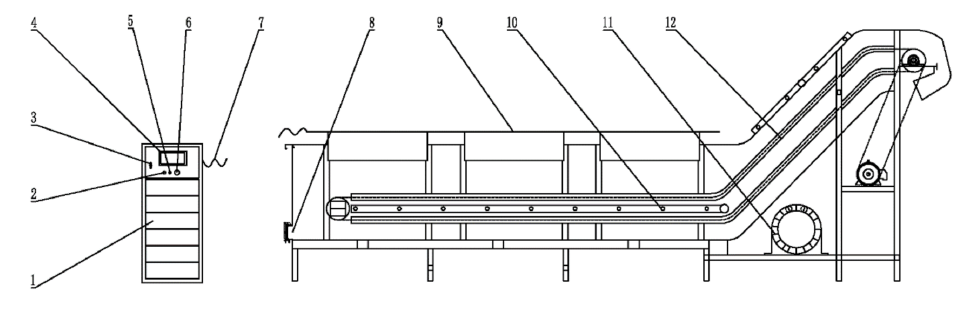
Figure 2. Structural diagram of ultrasonic cleaning